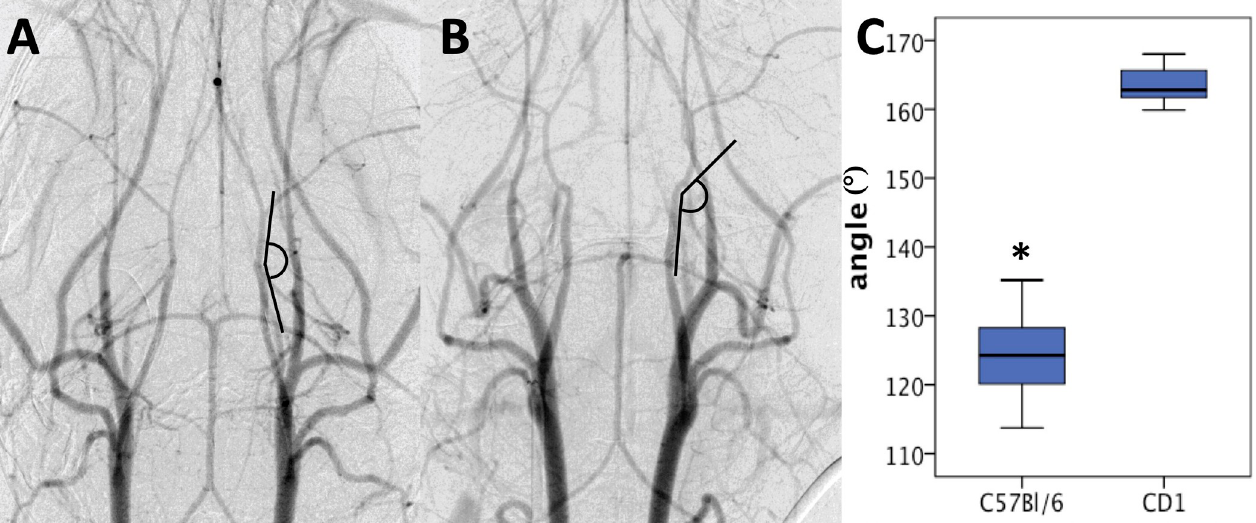
Fig 2. DSA in live mice demonstrates differences in neurovascular anatomy in CD1- and C57Bl/6-mice (A-C). The angle of the proximal intracranial ICA was measured in CD1- ( A ) and C57Bl/6-mice ( B ). Measurements revealed a significant difference of the mean ICA-angle between CD1- (163.54˚) and C57Bl/ 6-mice (124.54˚; p < 0.001) ( C